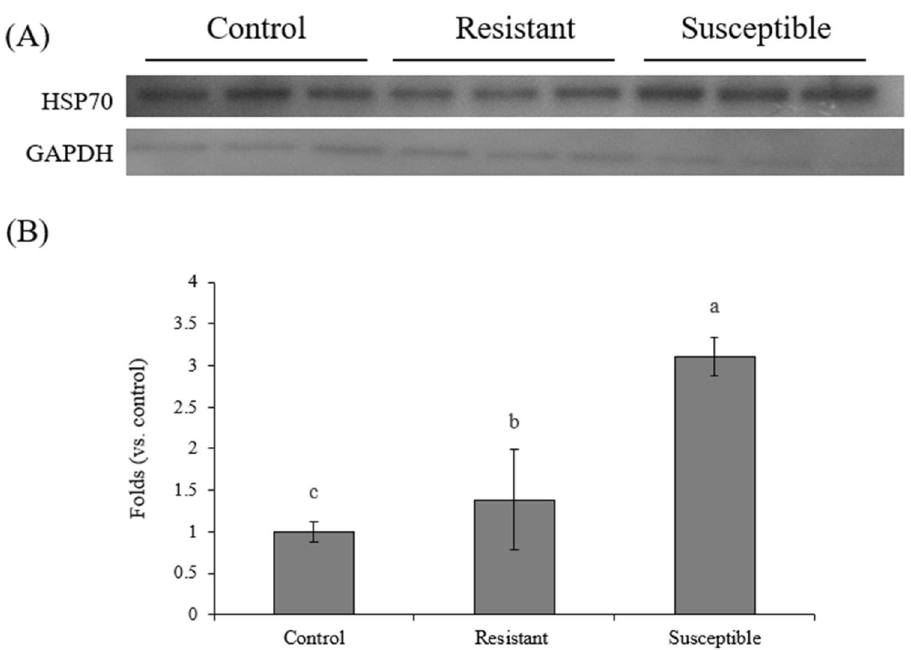
Figure 4. Protein expression levels of HSP70 and GAPDH in the adrenal glands of male L2 strain TCCs. ( A ) A reprehensive Western blot analysis of HSP70 and GAPDH. ( B ) Quantification of relative expression levels of each protein. Results are expressed as mean ± standard error (n = 5). The raw profiles is shown in Supplementary Fig. S3. a,b,c Superscripts indicate a difference between groups ( P <